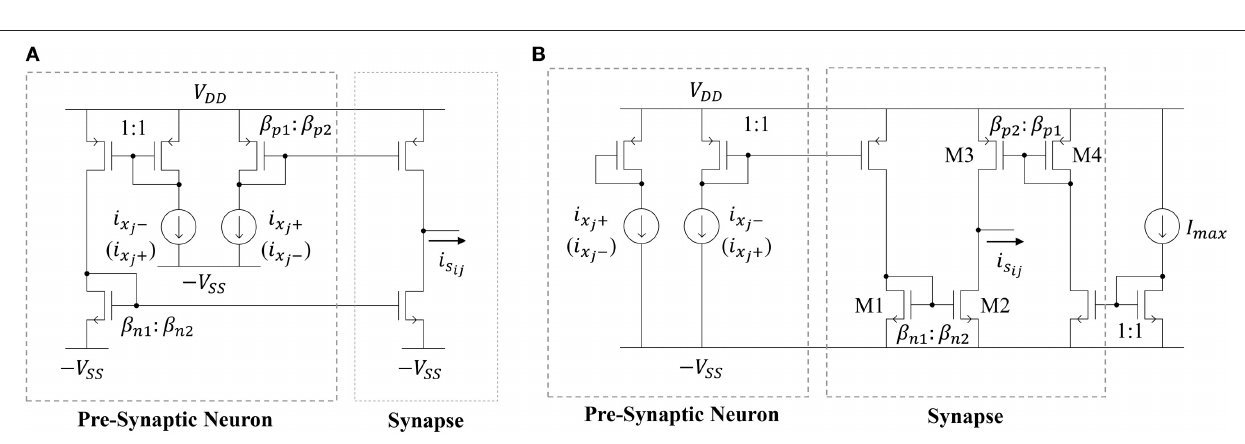
Frontiers in Neuroscience |